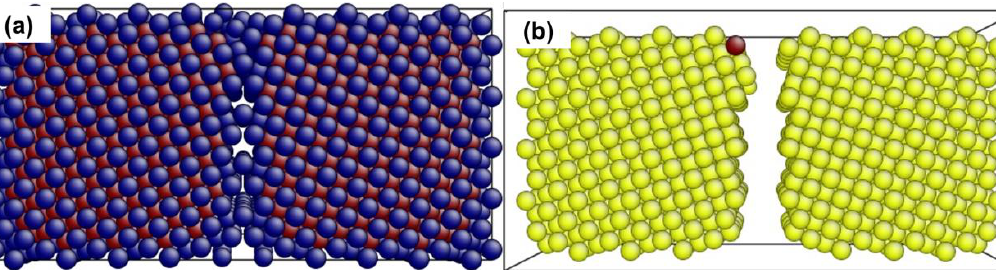
Figure 8. The computed minimum eigenvalue ( η 1 ) of matrix A vs. tensile displacement of the bicrystal simulation with a symmetric tilt grain boundary.